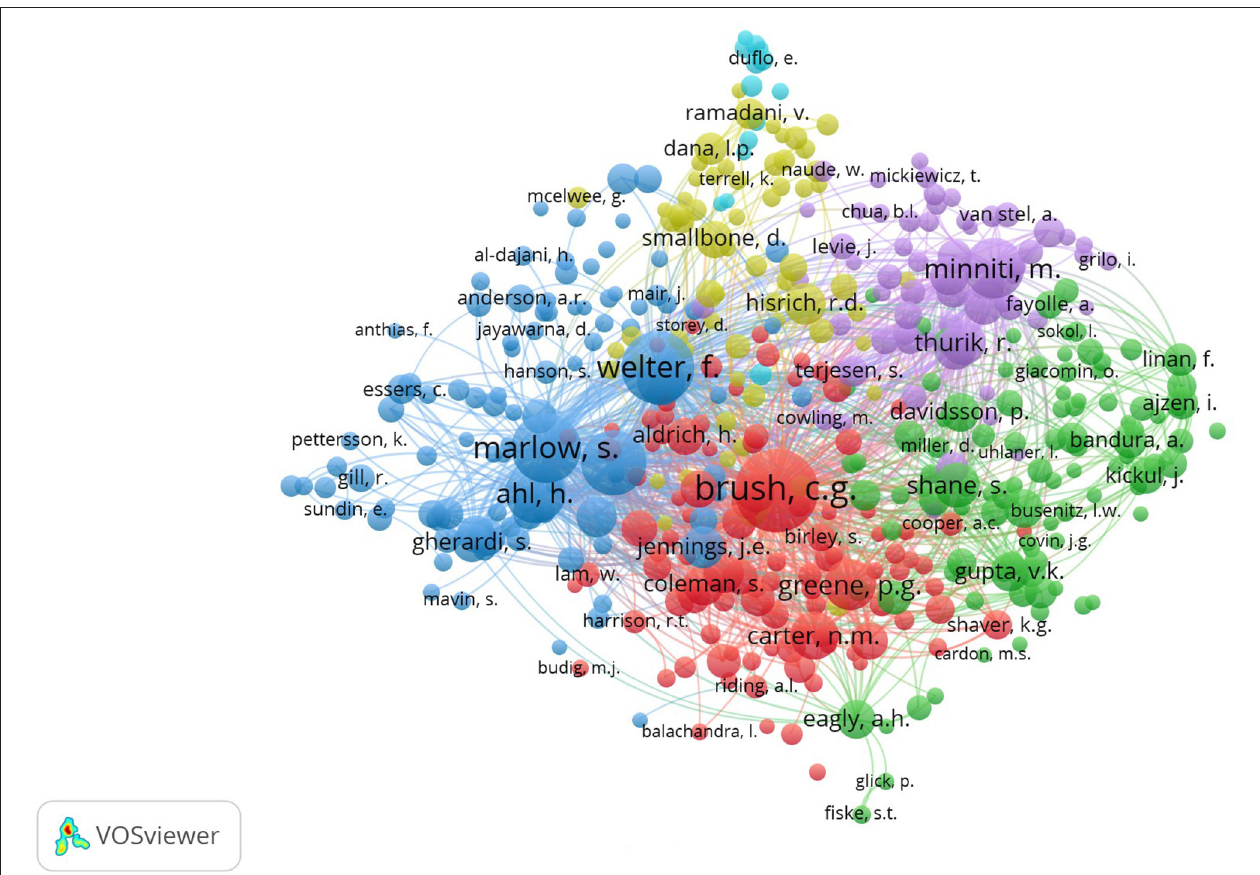
FIGURE 4 | Author co-citation analysis of the woman entrepreneurship literature.